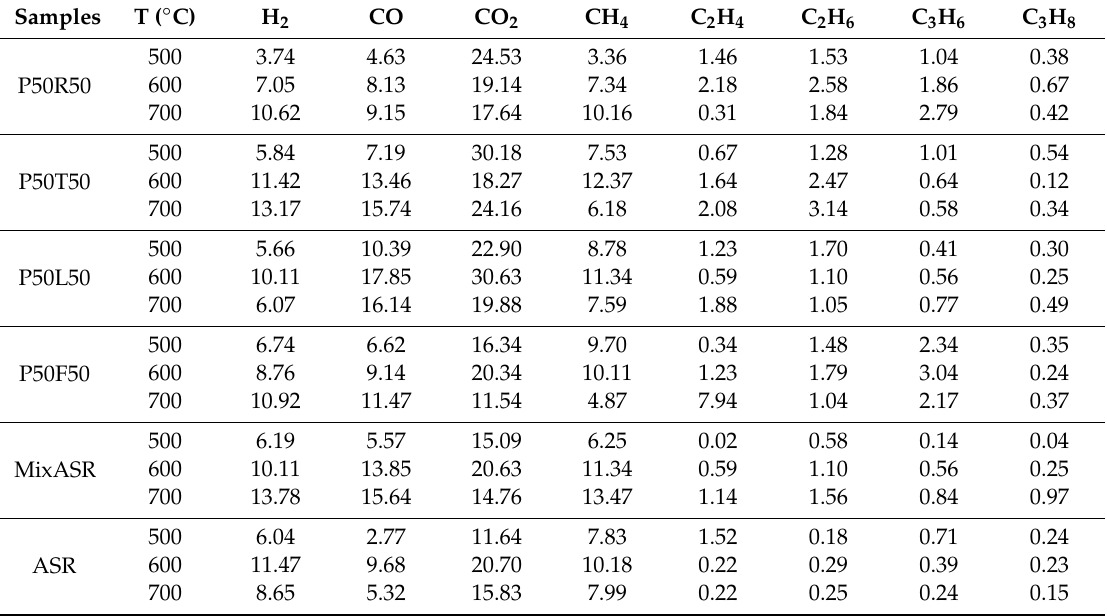
Table 6. The proportion of the main small molecule gases in the pyrolytic gas products.